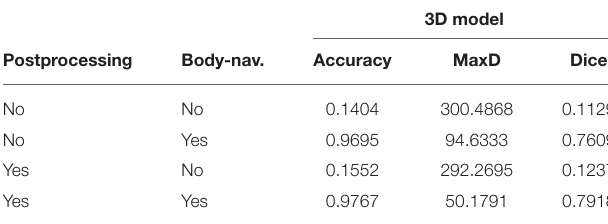
TABLE 2 | Evaluation of postprocessing in 3D segmentation